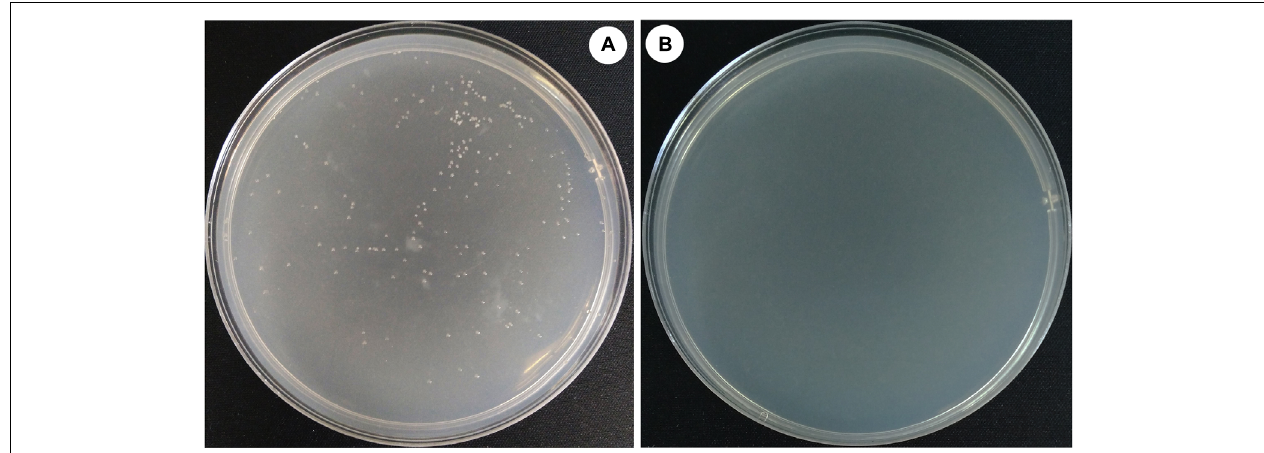
FIGURE 1 | Efficiency of the DNA uptake in Haloferax mediterranei . Plasmid pWL502 was taken as external DNA to transform strains of Hfx. mediterranei . The procedure of simulation of natural transformation was described by Chen et al. (2012). Cells of strains DF50- (cid:49) EPS (A) and DF50- (cid:49) EPS (cid:49) halH4 (B) were used as recipients.